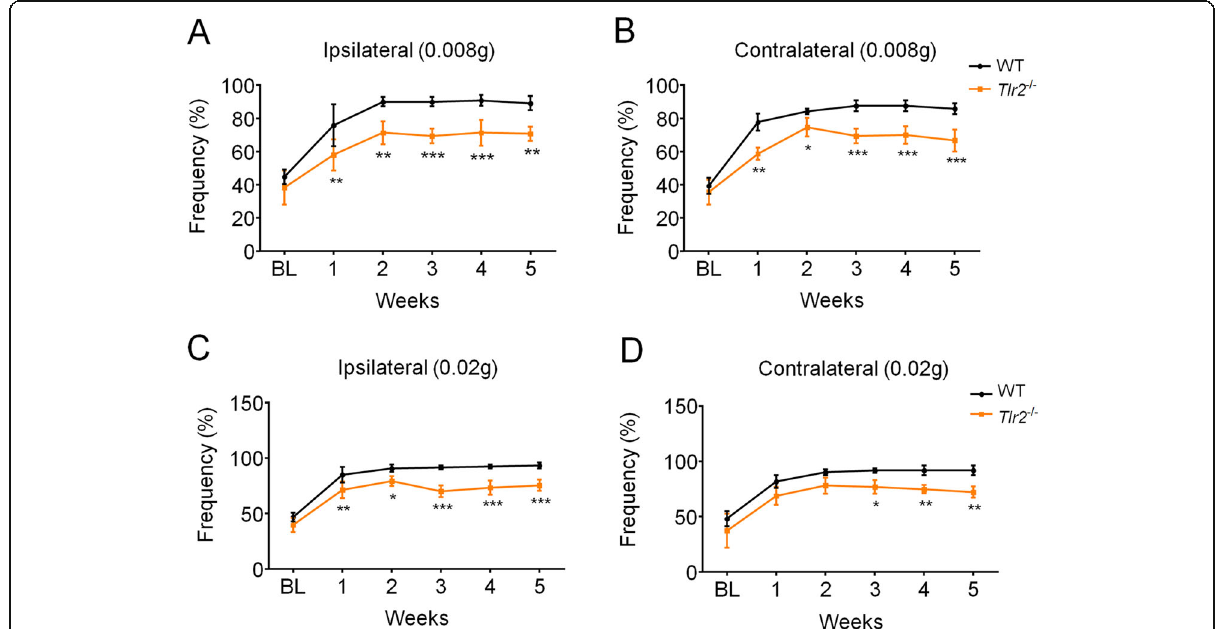
Fig. 5 Bilateral mechanical pain hypersensitivity following dIoN-CCI surgery in the wide-type and Tlr2 − / − mice. a - b At 0.008 g stimulus intensity, ipsilateral ( a ) and contralateral ( b ) mechanical pain hypersensitivity induced by dIoN-CCI group was significantly inhibited in the Tlr2 − / − mice compared with that of wild-type mice. c - d At 0.02 g stimulus intensity, ipsilateral ( c ) and contralateral ( d ) mechanical pain hypersensitivity induced by dIoN-CCI group was significantly inhibited in the Tlr2 − / − mice compared with that of wild-type mice. Data was expressed as Mean ± SEM. ( n = 6 each group, * P < 0.05, ** P < 0.01, *** P < 0.001 compared with the C57 dIoN-CCI group, two-way ANOVA with post-hoc Bonferroni